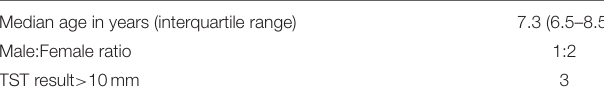
TABLE 1 | Demographic characteristics of 9 participants. Median age in years (interquartile